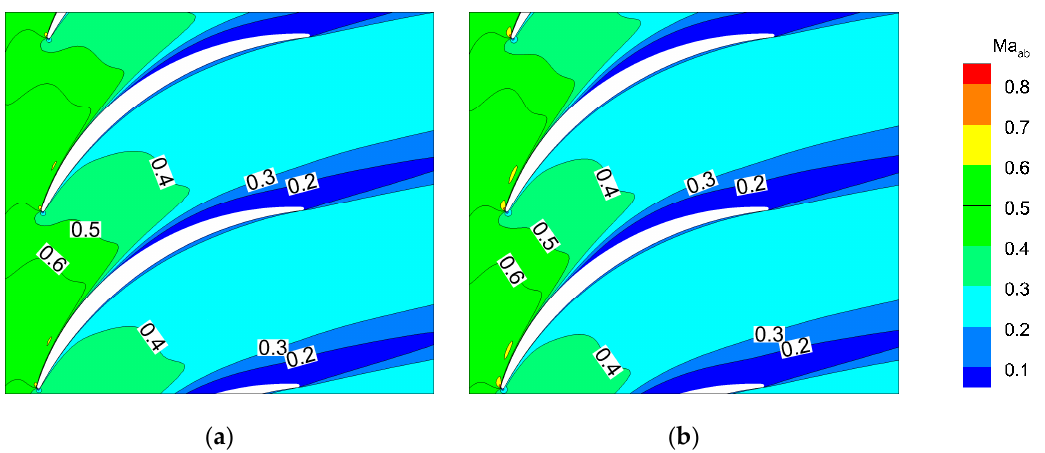
Figure 17. Absolute Mach number in 95% of the span height of second-stage stator from the peak efficiency condition to near stall condition. ( a ) Absolute Mach number at peak efficiency condition; ( b ) absolute Mach number at near stall condition.